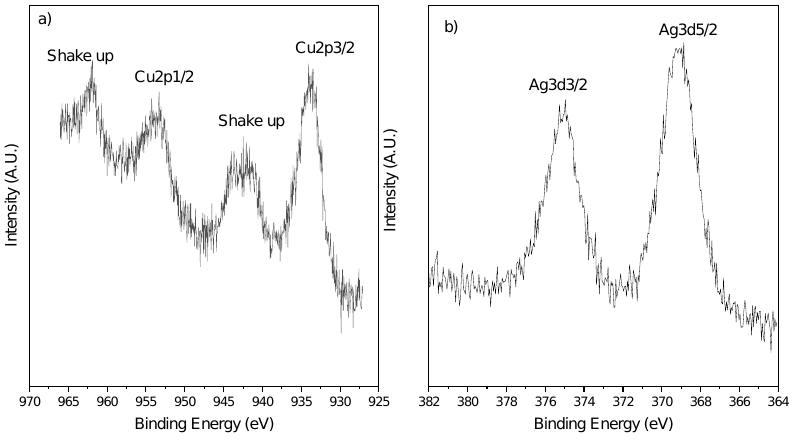
Figure 4. XPS region of 2.5Cu-2.5Ag/SiO 2 ( a ) Cu 2p and ( b ) Ag3d. Table 3. XPS results Ag3d5/2, Cu2p3/2, and O1s in eV; the relative percentages are in parentheses. Surface atomic ratio Cu/(Si + Ti) Ag/(Si + Ti) and Ag/Cu; the theoretical values are in